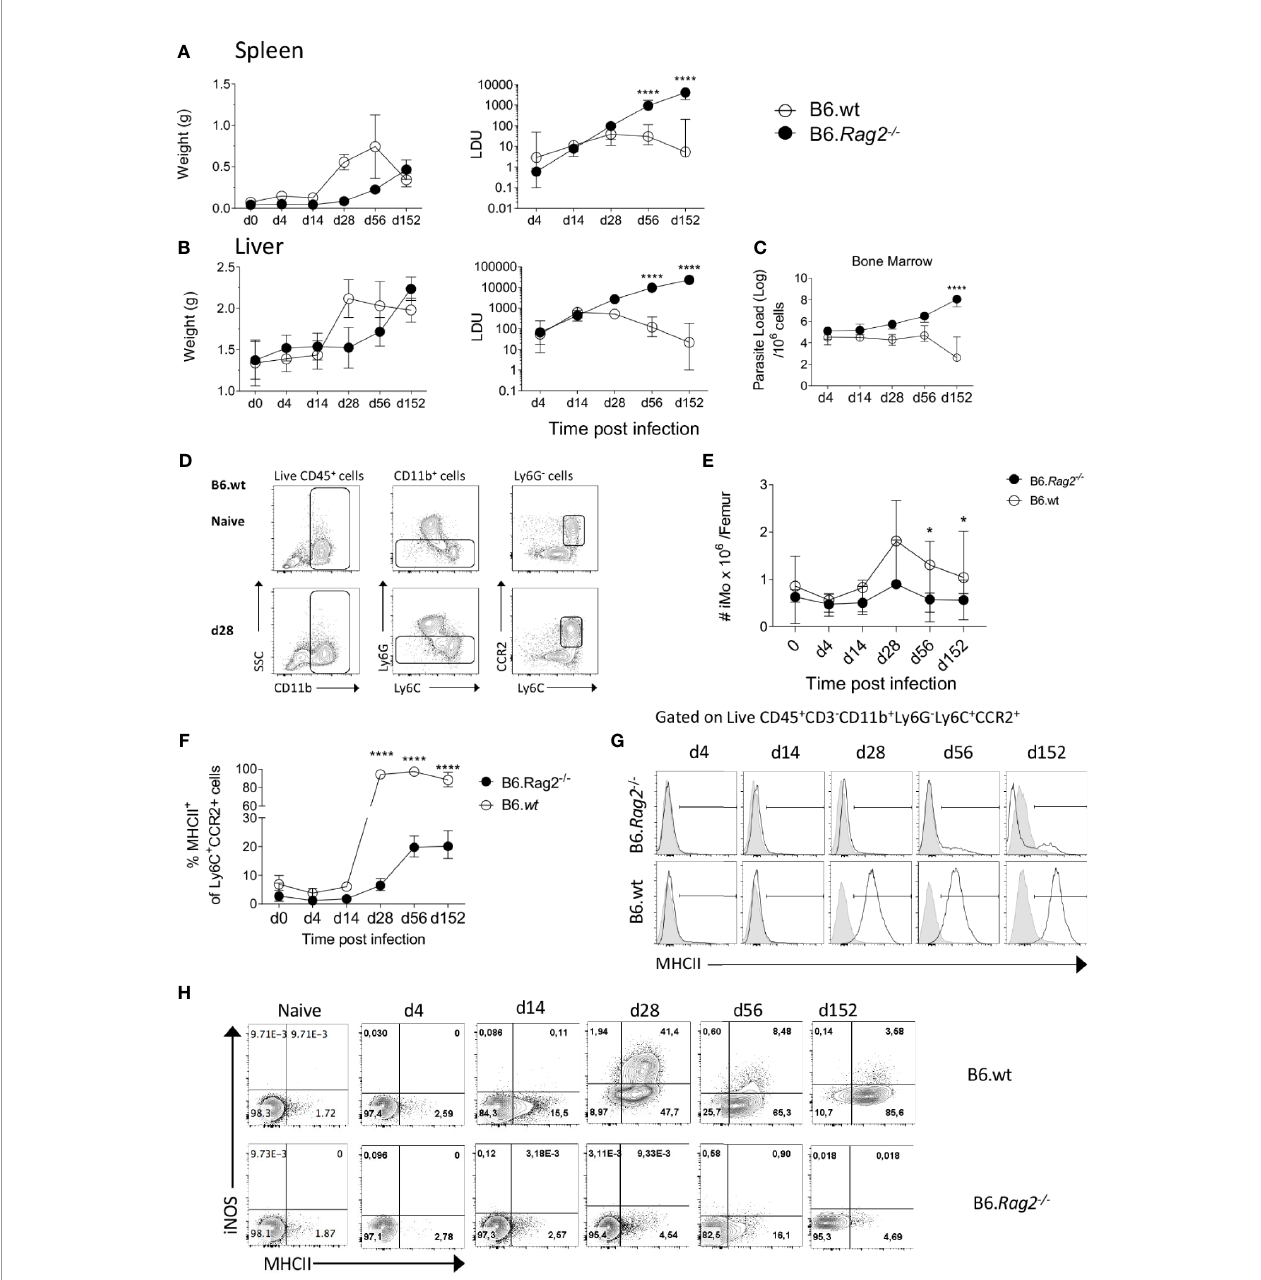
FIGURE 1 | Monocytes are activated during L. donovani infection in B6 but not in B6. Rag2 -/- mice. (A, B) Weight (left panel) and Leishman Donovan Unit (right panel) in the spleen (A) and liver (B) of B6 mice and B6. Rag2 -/- at different time point during the course of the infection. Two-way factorial analysis applied to LDUs in (A, B) : Spleen P=0.001, Liver P=0.001; statistical power: Spleen 94%, Liver 99%; n ≥ 7; post hoc test EMM: statistical difference reached in spleen and liver at day 56 and day 152 (P<0.0001; ****). (C) Parasite load per one million cells in the bone marrow measured by limiting dilution assay. Two-way factorial analysis applied: P=0.09; statistical power: 32.3%; n ≥ 3; post hoc test EMM: statistical difference reached at day 152 (P<0.0001;****). (D) Gating strategy to identify Ly6C monocytes in BM. (E) Absolute number of iMo cells per femur. Two-way factorial analysis applied: P=0.165; statistical power: 98.5%; n ≥ 7; post hoc test EMM: statistical difference reached at day 28, day 56 and day 152 (*; P=0.014, P=0.036 and P=0.046), respectively. (F, G) MHCII expression on BM Ly6C + CCR2 + cells shown as percentage (F) and as representative fl ow histogram plots (G) in B6 and B6. Rag2 -/- mice during the course of the infection. Two-way factorial analysis applied in (F) : P=0.001; statistical power: 99%; n =4; post hoc test EMM: statistical difference reached at day 28, day 56 and 152 (P<0.0001; ****). (H) iNOS and MHCII expression on Ly6C + CCR2 + monocytes. Data are derived from analysis of 8 to 10 individual mice (4 to 5/experiment) of each strain at each time point pooled from two independent experiments and are shown as mean ± SD. Data in (G, H) are representative plots, including lower and upper range of MHCII expression at day 14. In (A – F) median with 95% CI is